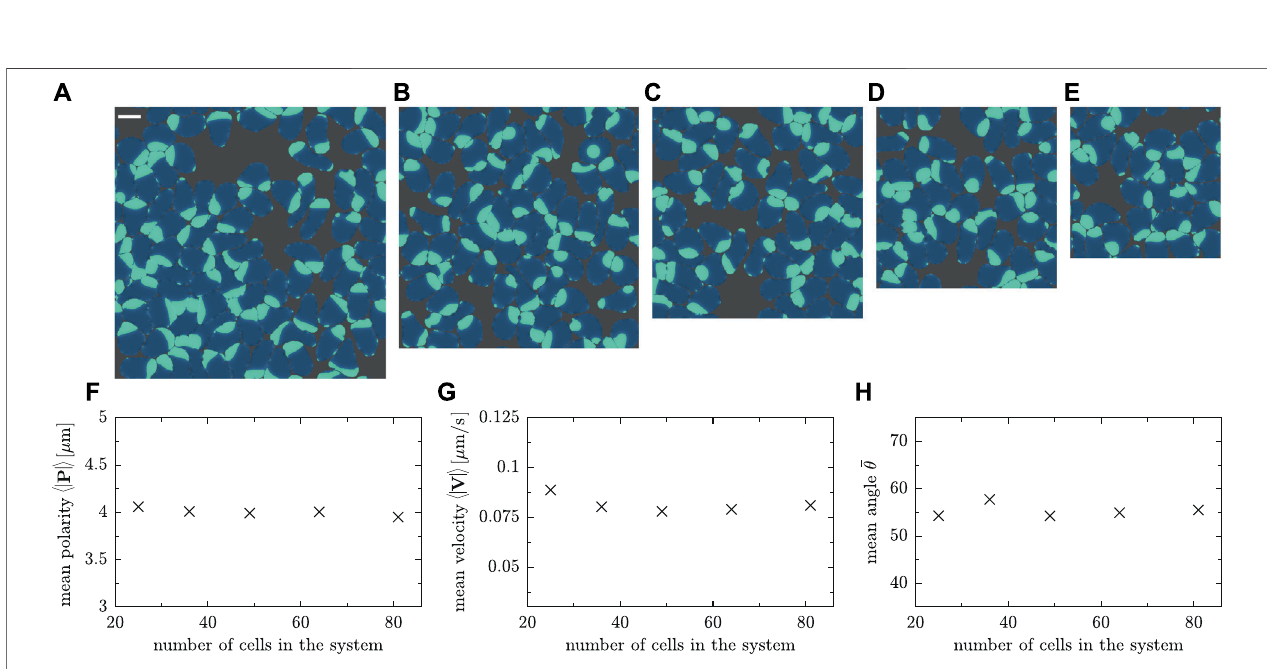
FIGURE11| Snapshotsofsimulationswiththesamepackingfraction ρ R =0.78.Thenumberofcellsandthesidelengthare (A) 81cellsand L =108 μ m , (B) 64cells and L =96 μ m (Movie SM9), (C) 49cellsand L = 84 μ m (MovieSM10), (D) 36cellsand L =72 μ m , (E) 25cellsand L =60 μ m . (F) Meanpolarity, G meanvelocity and (H) mean angle between velocity and polarity vector for a fi xed packing fraction but various cell numbers in the system.